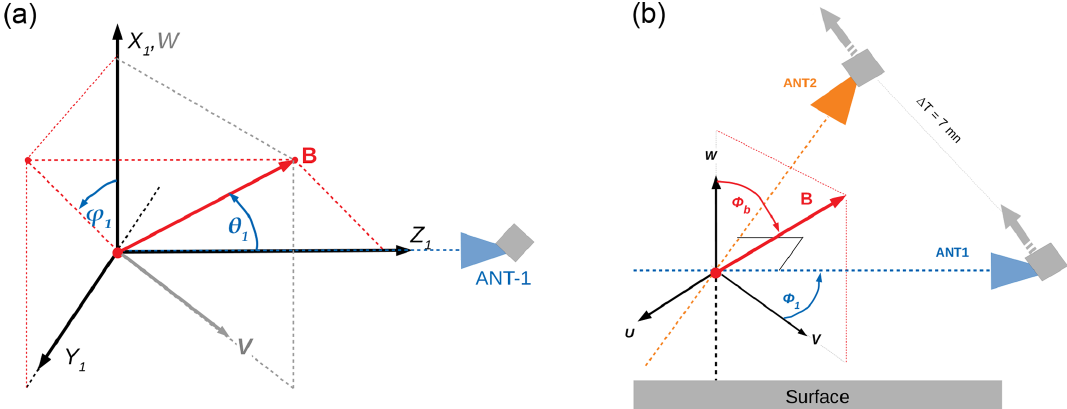
Figure 4. (a) Cartesian and spherical frames used for the radiative transfer calculation. The x and z axes are along the vertical axis (W) and the LOS, respectively. (b) Frame for describing the observation of the same air mass from the forward (ANT1) and aftward (ANT2) antennas. The background geomagnetic field ( B ) is at first approximation in the meridional plane.